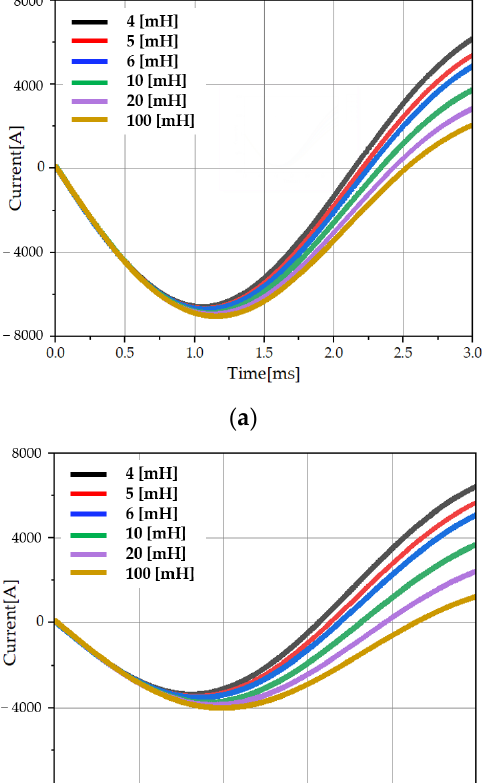
Figure 8. Plate displacement and speed simulation results: plate 10 mm movement after 2 ms when current is applied to TC.